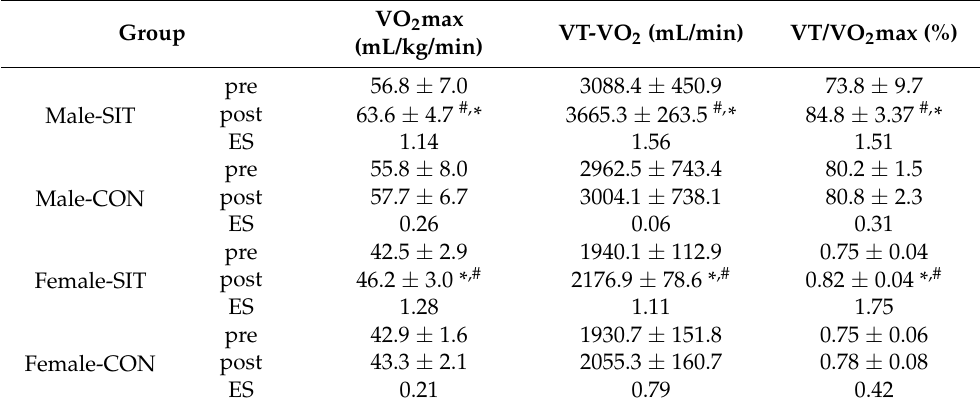
Figure 2. Within- and between-group differences in YO-YO Intermittent Recovery Test Level 2 (IR2) distance and lactate clearance rate for SIT and CON groups before and after intervention. Note: * Indicates significant difference between SIT and CON group, p < 0.05; # indicates significant within-group difference before and after intervention, p < 0.05; ES: effect size. Table 5. Within- and between-group differences in gas metabolism analysis for SIT and CON groups before and after